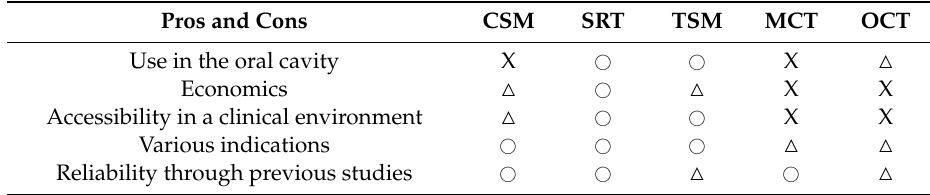
Table 2. Pros and cons with cross-sectional method (CSM), silicone replica technique (SRT), triple scan method (TSM), micro-computed tomography (MCT), and optical coherence tomography (OCT) in the presented study. Circle means good evaluation.